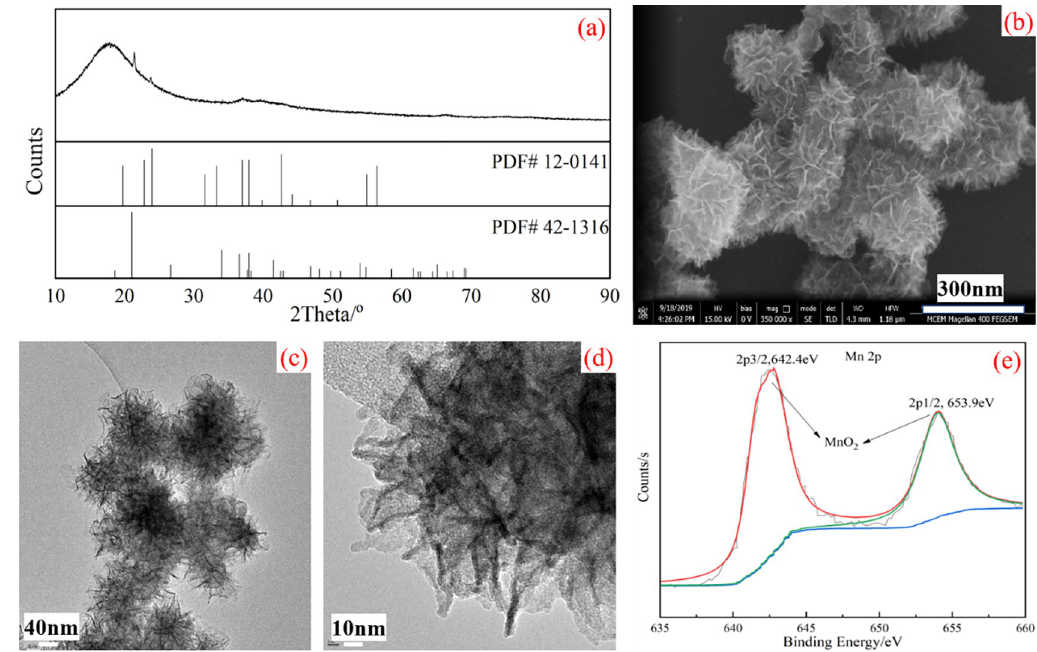
Fig 1. Characterization of the flower-like MCE particles: (a) XRD pattern, (b) SEM image, (c) TEM image at a low magnification, (d) TEM image at a high magnification, and (e) XPS spectrum.